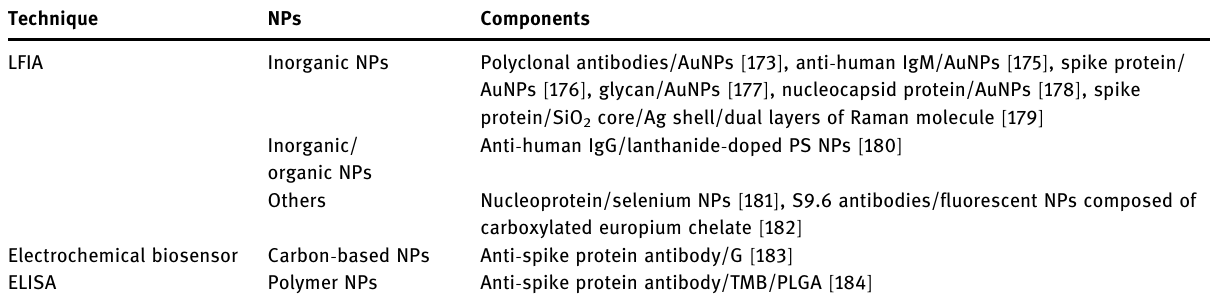
Table 5: Various SARS - CoV - 2 diagnostic platforms in NPs for quick and precise detection